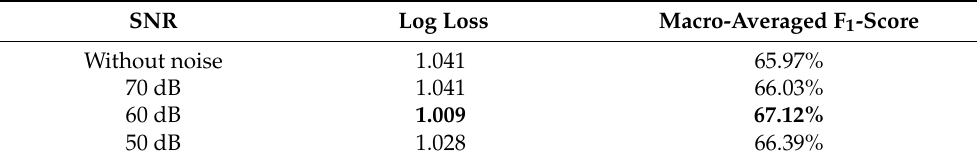
Table 6. Performance comparison with various signal-to-noise ratios (SNRs) of additive noise.